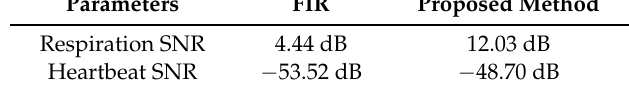
Figure 12. Performance of separation.